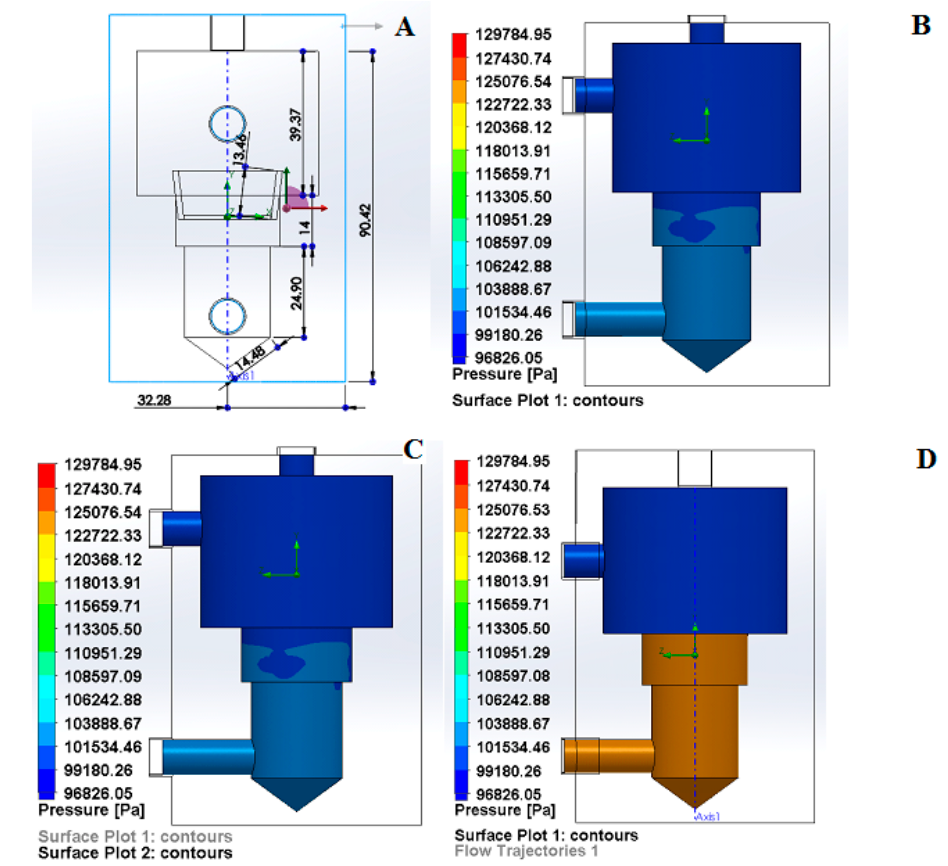
Figure 8. ( A ) Schematic of the bioreactor chamber with transwell in SolidWorks ® (units in mm); ( B ) Surface contour plot of empty bioreactor; ( C ) Surface contour plot of bioreactor with simulated cell suspension in transwell insert; ( D ) Surface contour plot of bioreactor with simulated articular cartilage in transwell insert.